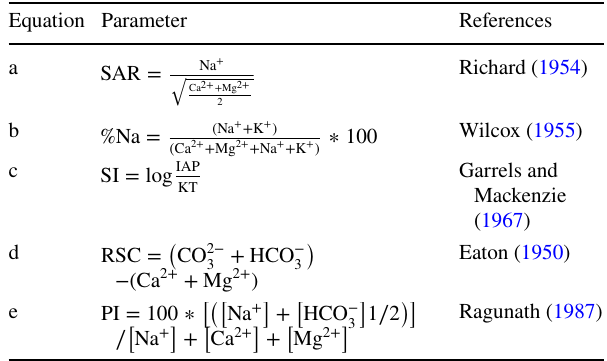
Table 2 Equations used in calculating SAR, %Na, SI, RSC, and PI Equation Parameter